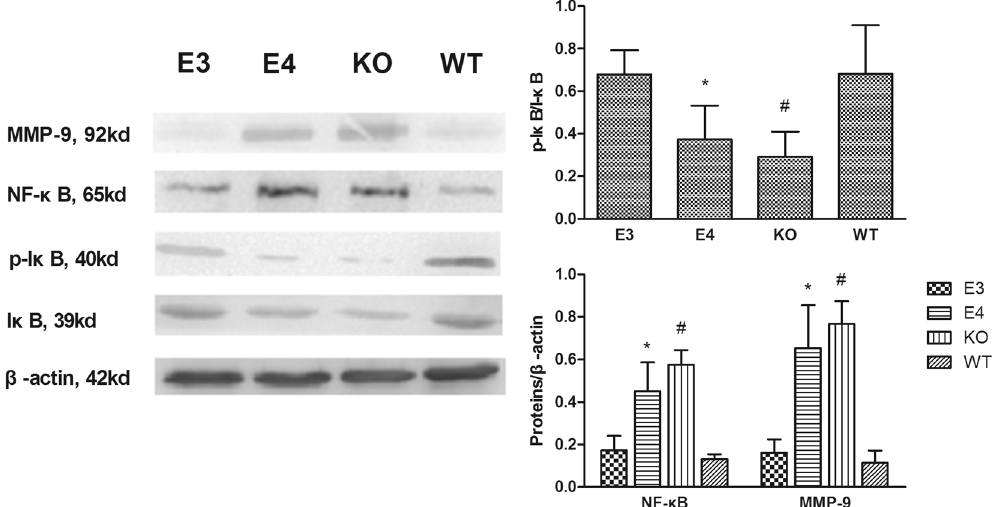
Figure 6. At day 7 after injury, I- κ B phosphorylation and NF- κ B suppression were significantly more obvious in E3 and WT mice compared with E4 mice. The KO mice presented less phosphorylation than the WT mice. ( * P < 0.01 vs E3 and WT mice; # P < 0.01 vs WT mice. N = 8) The expression of NF- κ B and MMP-9 was significantly higher in the E4 mice than in the E3 and WT mice. Additionally, more expression was found in the KO mice than in WT mice. ( * P < 0.05 vs E3 and WT mice; # P < 0.001 vs WT mice. N = 8) The data are presented as the mean ±